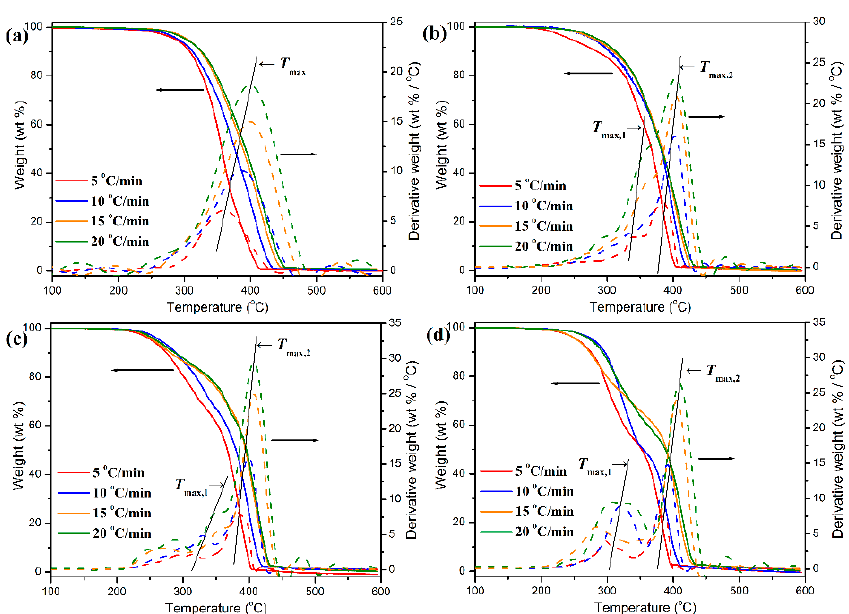
Figure 15. TGA and DTG thermograms of ( a ) pure POM fiber and POM / PLLA bicomponent fibers containing ( b ) 5, ( c ) 10, and ( d ) 20 wt % PLLA at the ultimate draw ratios.